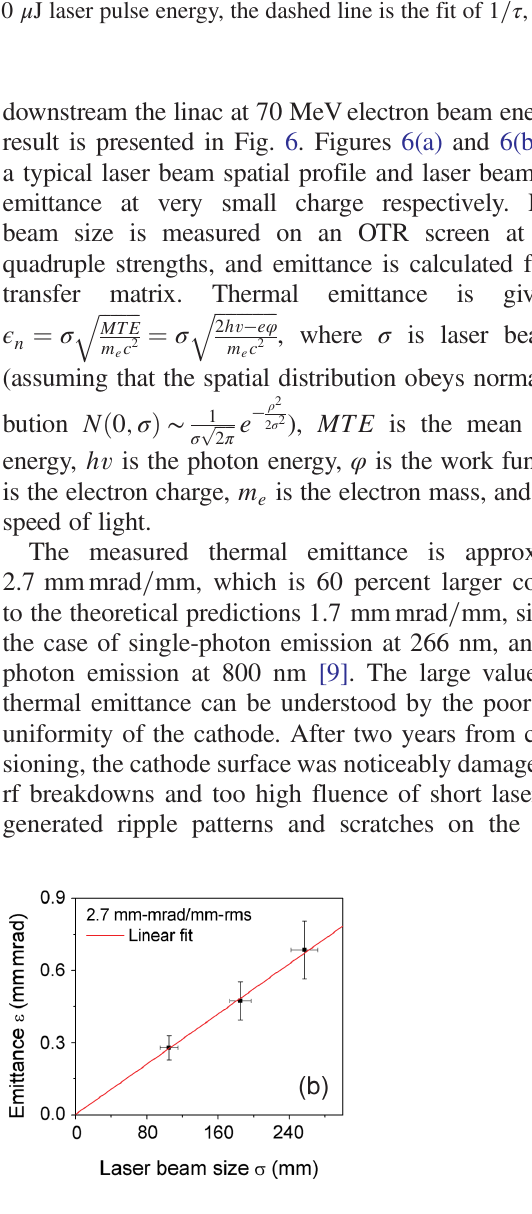
FIG. 6. Laser beam spatial profile (a) and beam size vs emittance (b) at very low bunch charge. The red line is linear fit of the